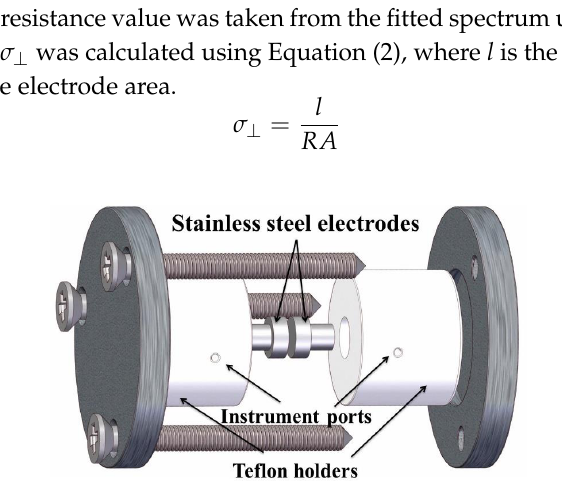
Figure 1. Cylindrical conductivity cell sketch.